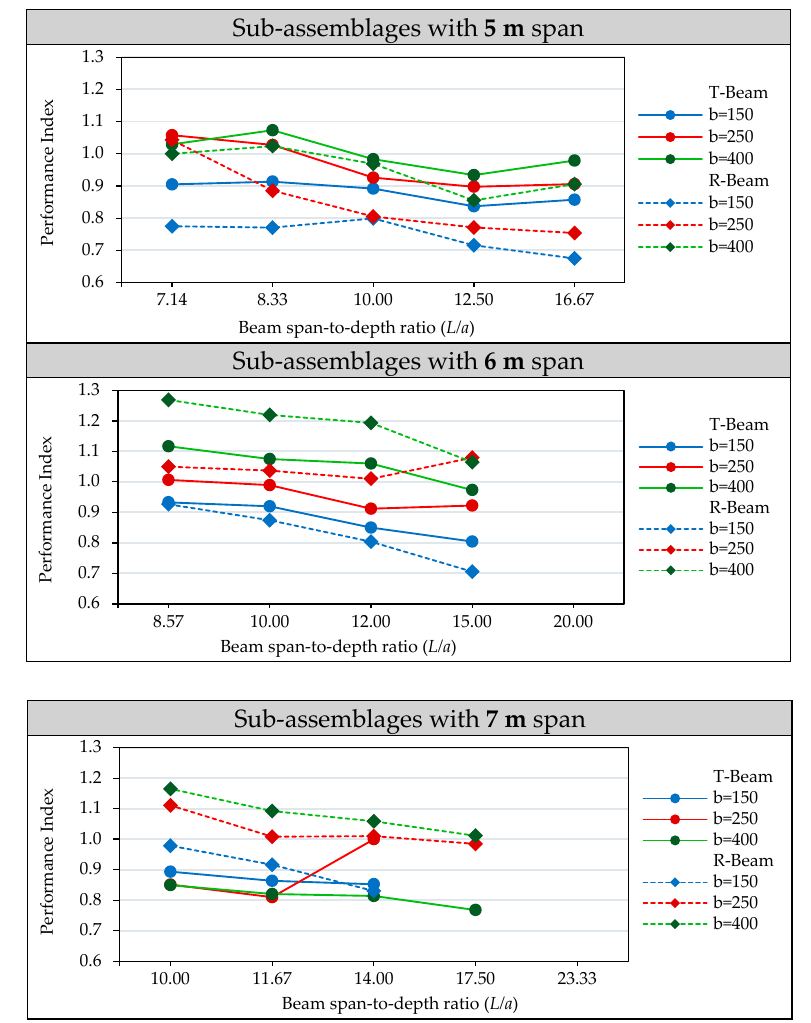
Figure 9. The performance index.